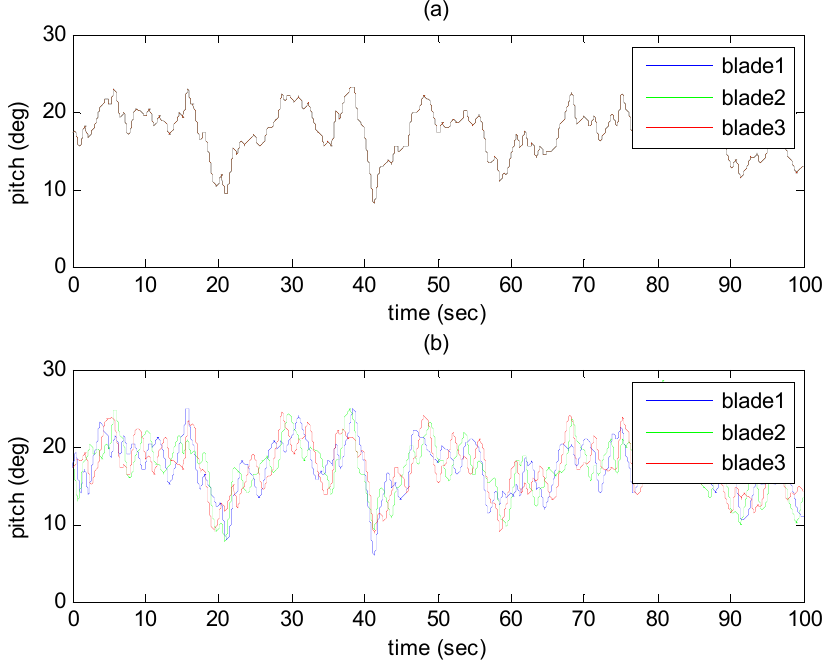
Figure 12. Responses of pitch commands: ( a ) without IPC; ( b ) with